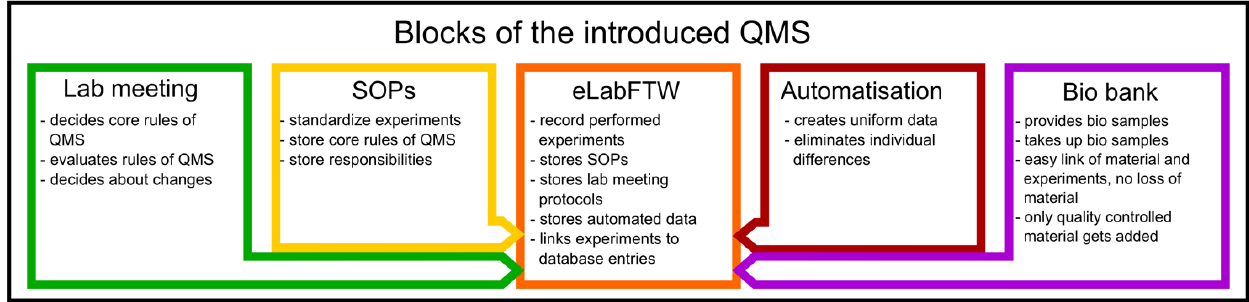
Figure 1. Blocks that form the QMS and their function inside of it. SOP: Standard operation procedure, QMS: Quality management